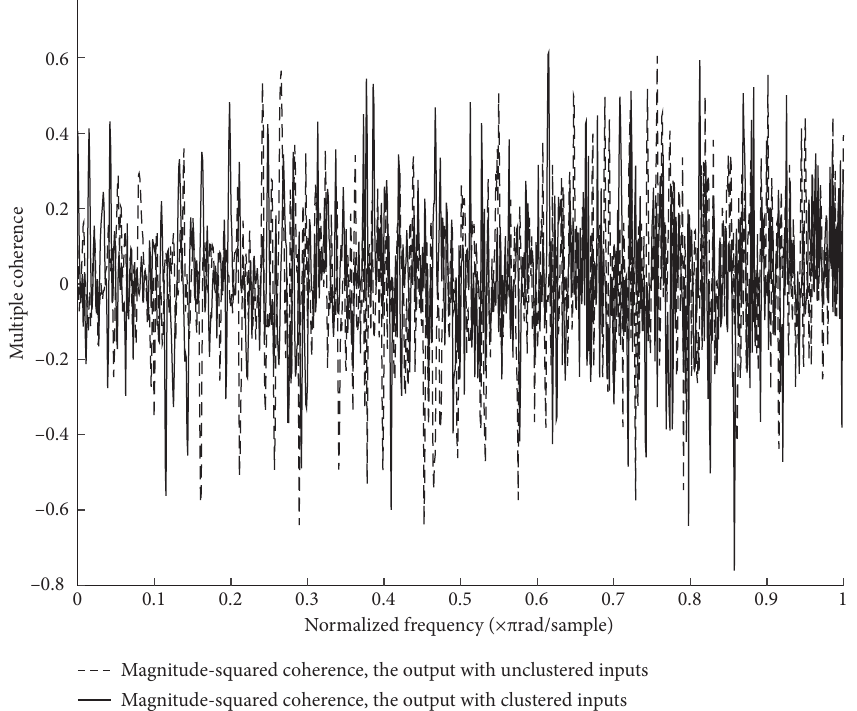
Figure 5: MSC of clustered and unclustered inputs with the system output y for noise variance of σ 2 � 0 . 10 2